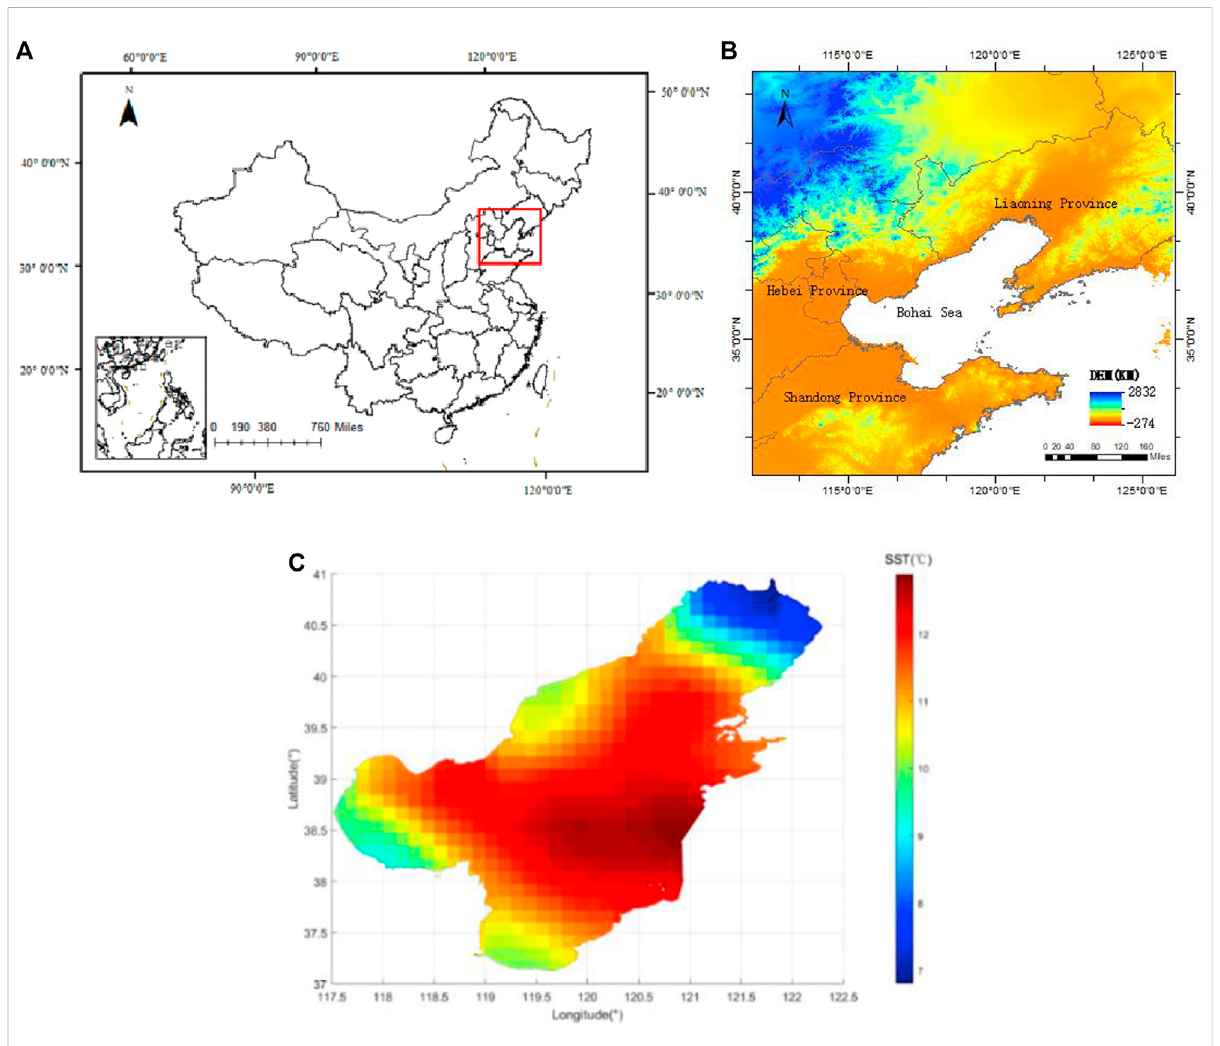
FIGURE 1 Map of China (A) . Elevation map of the Bohai Sea (B) . SST of the Bohai Sea (C)